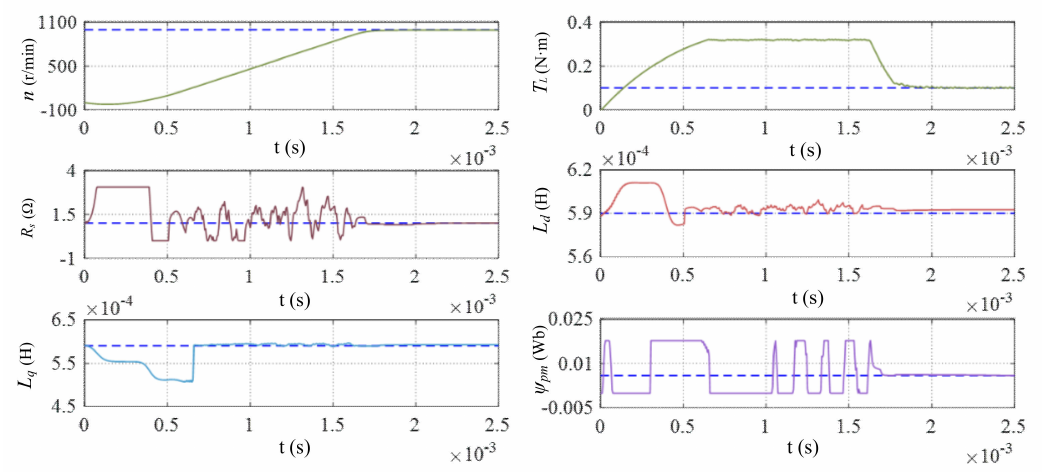
Figure 14. Parameter identification results when changes both load and